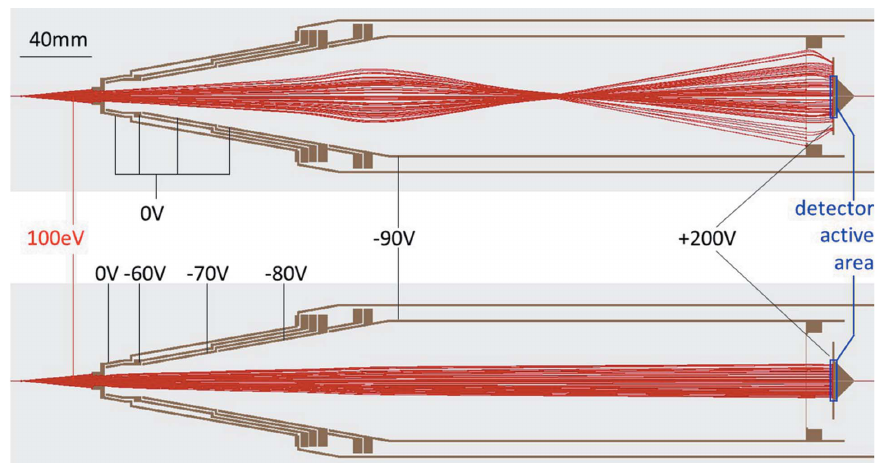
Figure 2 Effect of focusing and retarding voltages on the simulated particle